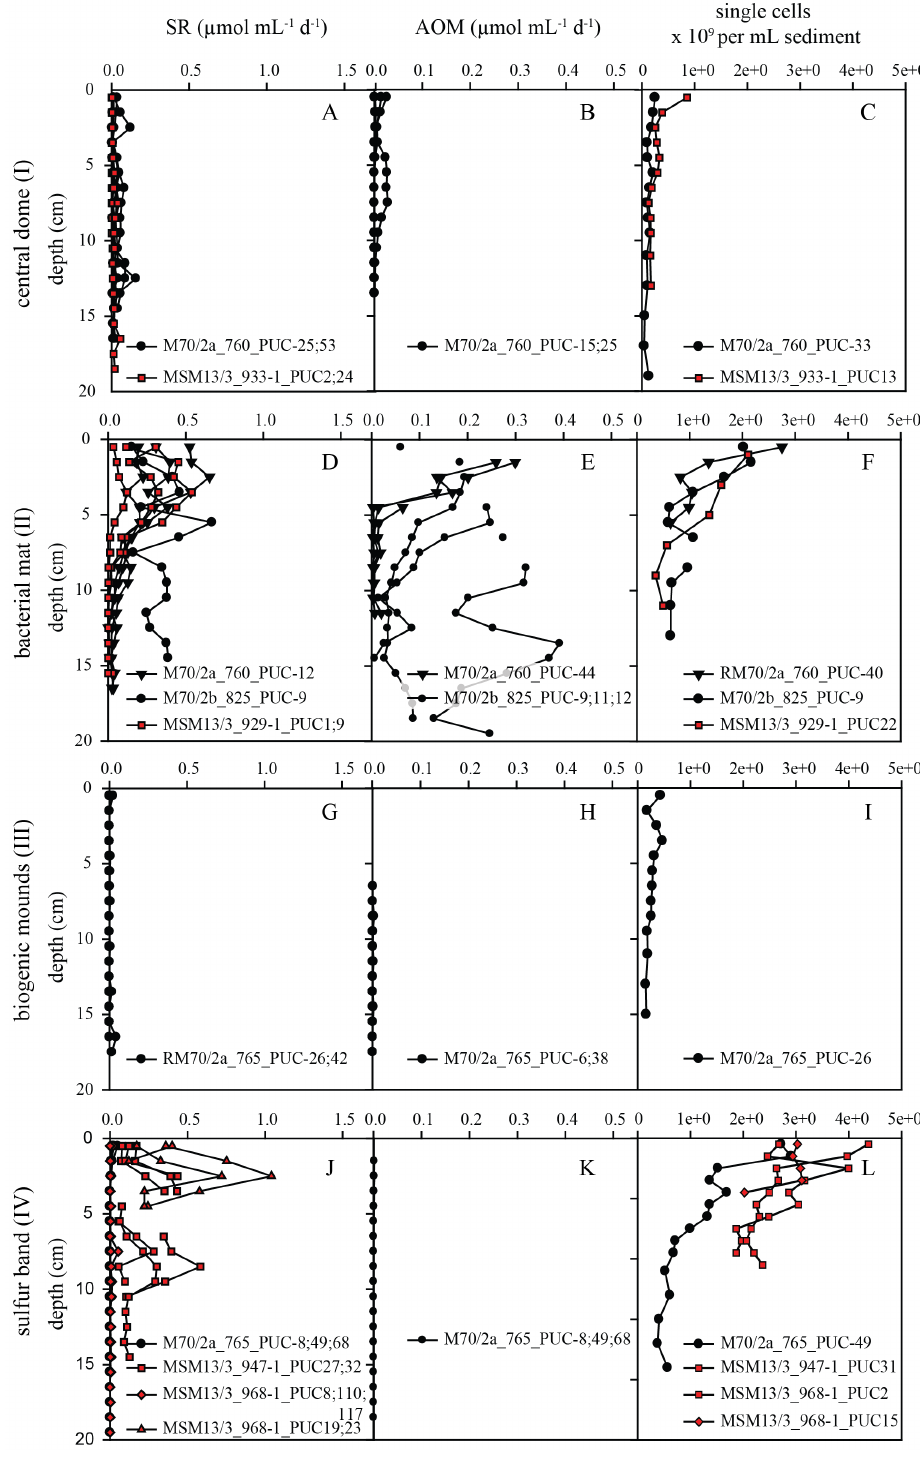
Fig. 6. Biogeochemistry of the different habitats at Amon MV. Sulfate reduction (left panel), anaerobic oxidation of methane (middle panel), and single cell counts (right panel) at (I) the central dome (A) , (B) , (C) ; (II) bacterial mats (D) , (E) , (F) ; (III) biogenic mounds (G) , (H) , (I) ; (IV) sulfur band (J) , (K) , (L) . Replicates of one station are represented with the same symbol and the same year with the same color (black = 2006, red = 2009). Note: sulfate reduction and anaerobic oxidation of methane are on different